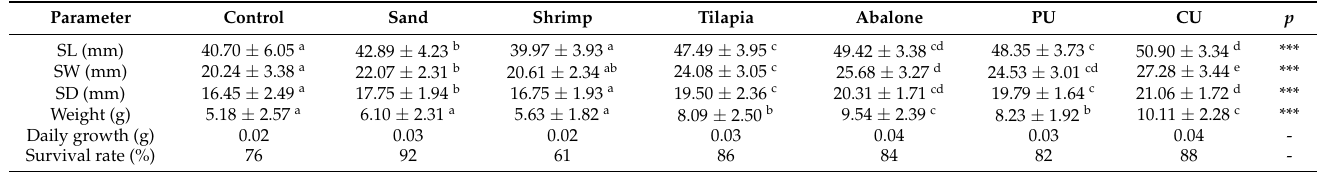
a,b,c,d,e Lowercase letters indicate significant differences (Tukey’s HSD; p < 0.05) between coculture treatments at 270th day post initiation of the outdoor polyculture experiment. Daily growth: (mean final weight–mean initial weight)/270 days). *** ANOVA; p <